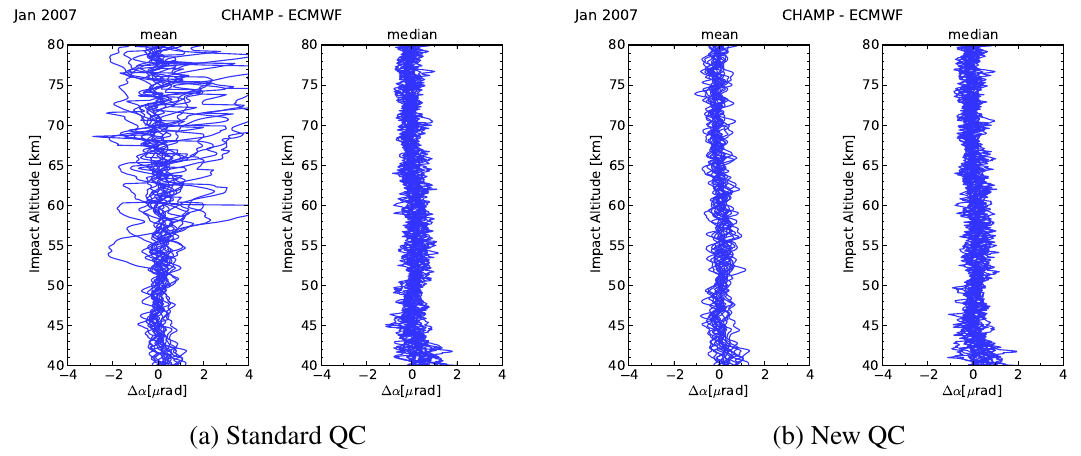
Fig. 1 : Difference between observed bending angle means and medians to co-located ECMWF Figure 1. Difference between observed bending-angle means and medians on the one hand and colocated ECMWF analysis data on the other, comparing the results with standard Qualitiy Control (QC) to the results where an additional bending-angle QC has been applied.